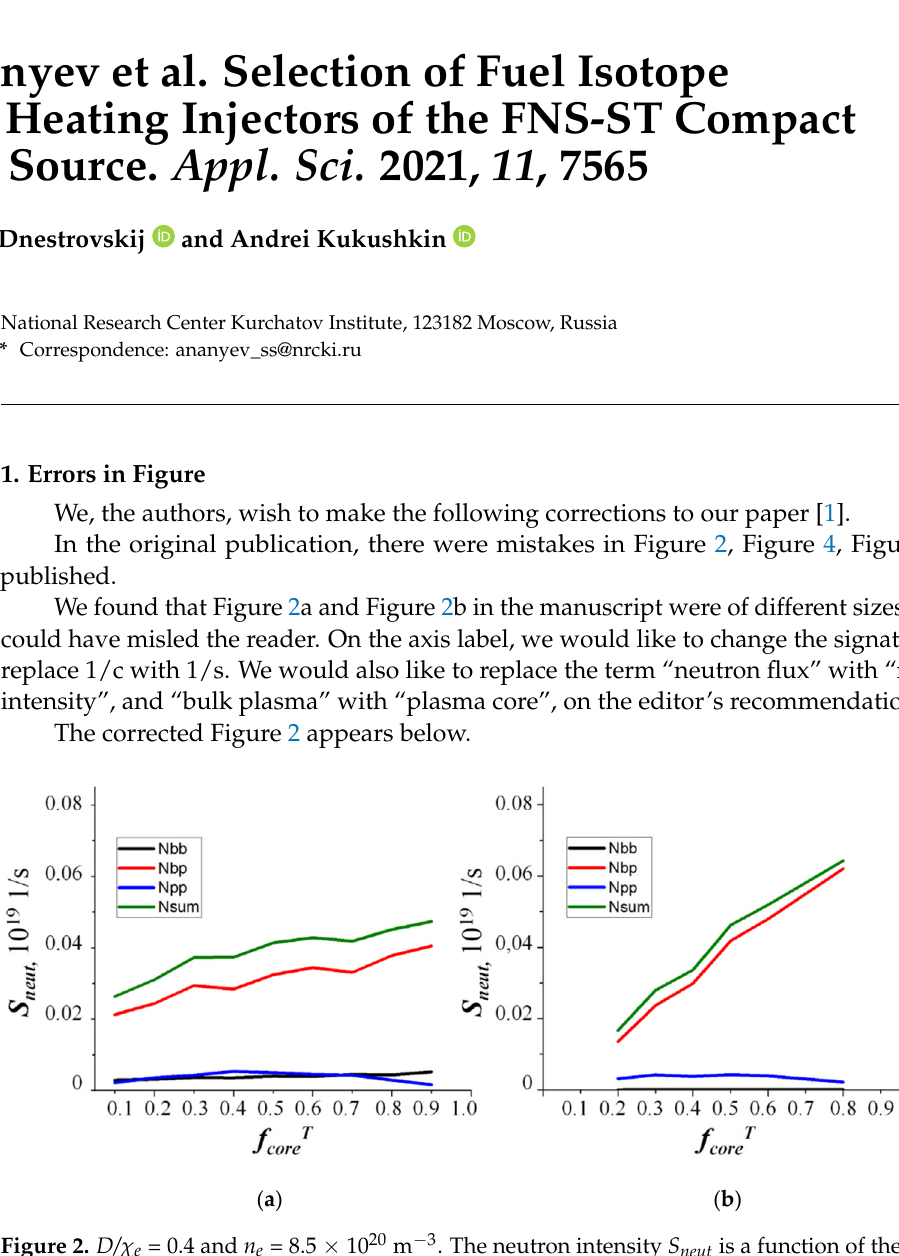
Figure 2. D/ χ e = 0.4 and n e = 8.5 × 10 20 m − 3 . The neutron intensity S neut is a function of the fraction of tritium f coreT in the plasma for the D + T ( a ) and D ( b ) beams. Different colors correspond to the neutron intensity components contributing to the total neutron intensity S sum (—-). S bp (—-) is the intensity due to fast ion interaction with plasma, S pp (—-) is the intensity due to the plasma–plasma fusion mechanism, and S bb (—-) is the intensity due to interaction between the fast